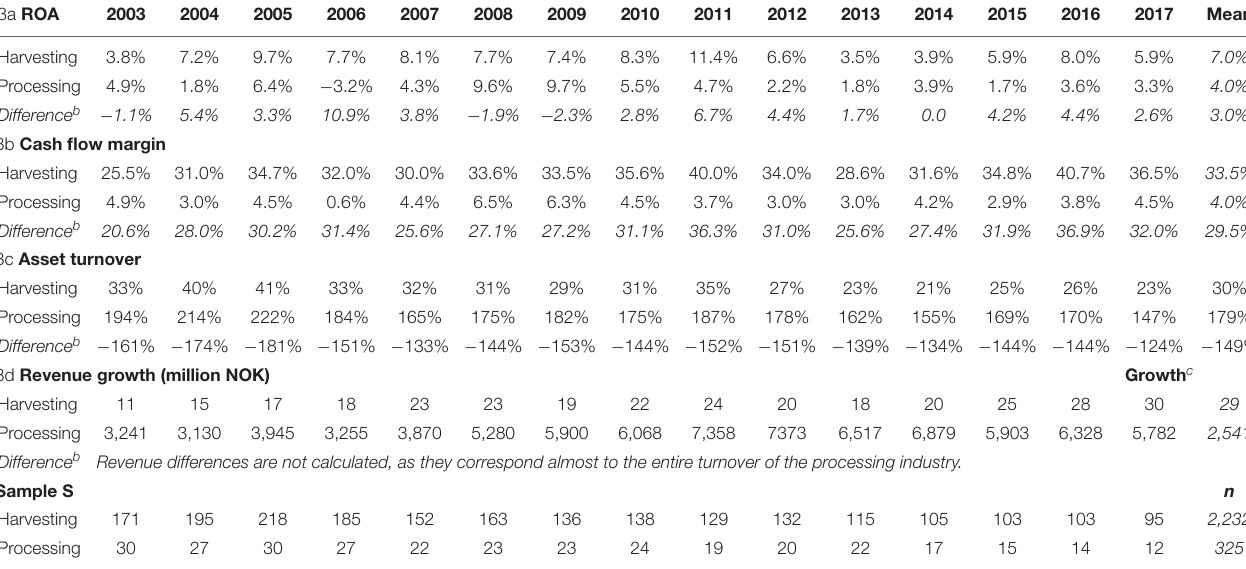
a All figures are based on weighted averages and expressed in current Norwegian kroner (NOK). As of May 2021, NOK 10 ≈ EUR 1. b A paired t-test assuming unequal variances showed significant differences between the two groups (p < 0.001). c The values represent the absolute growth in revenues from 2003 to 2017 (million NOK). This aspect is equivalent to a mean annual growth rate of 6.7% for the harvesters and 3.9% for the